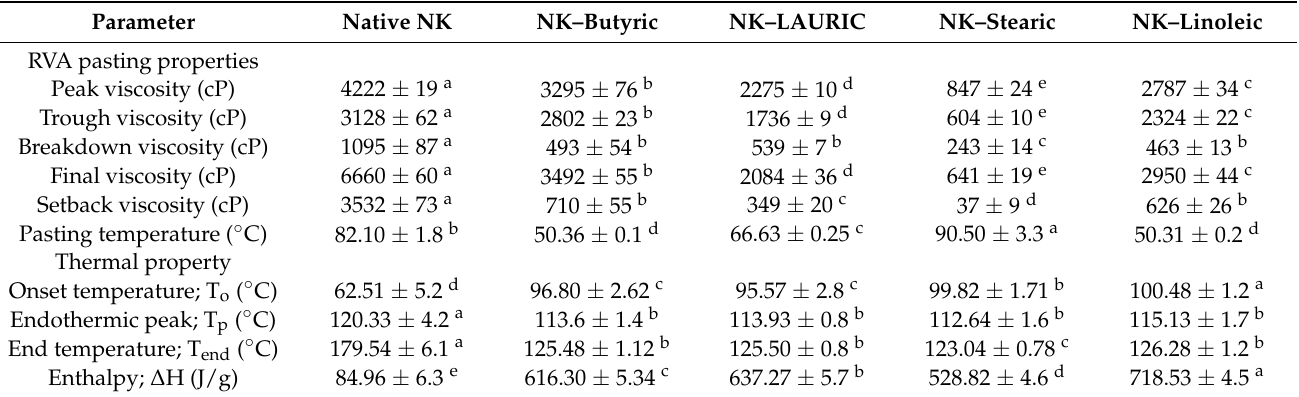
Table 2. Pasting and thermal properties of native Noui Khuea (NK) starch and NK starch–lipid complexes with varying fatty acid chain